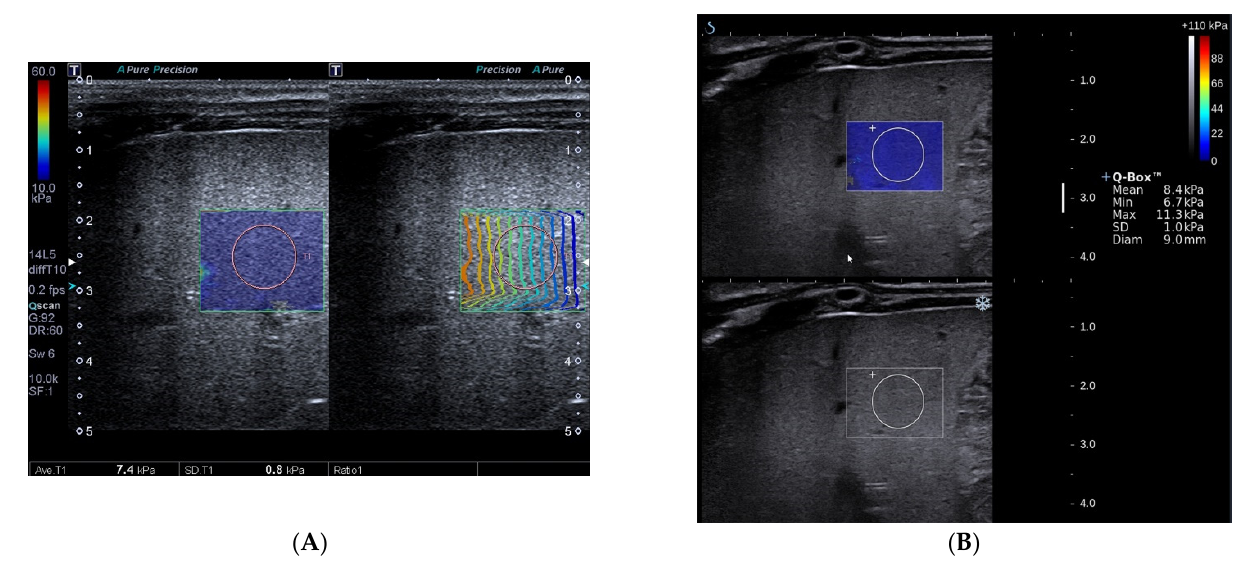
Figure 2. Toshiba shear wave elastography measurements ( A ) and Supersonic shear wave elas- tography measurements ( B ) in a 78-day-old boy. The final diagnosis of the patient was non-biliary atresia (transient cholestasis of unknown etiology) and Metavir fibrosis stage was F3. A, Speed smart map of Toshiba shear wave elastography (left) shows the mean liver stiffness value was 7.4 kPa. The propagation map of Toshiba shear wave elastography shows regularly parallel contour lines (right). B, Supersonic shear wave elastography measurement in the regions of interest (bottom, blue areas) shows the mean liver stiffness value was 8.4 kPa.